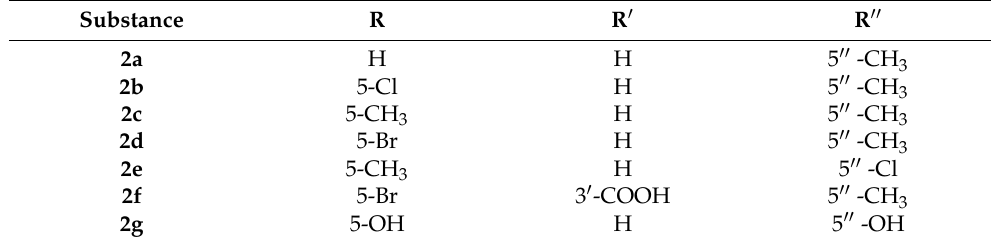
Table 1. Synthesised quingdainone variants with their respective substituents.